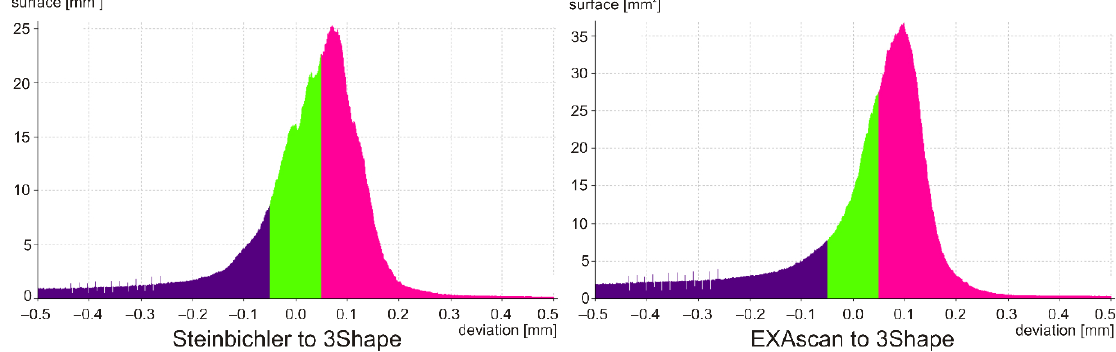
Figure 9. Comparison of scanner outputs.